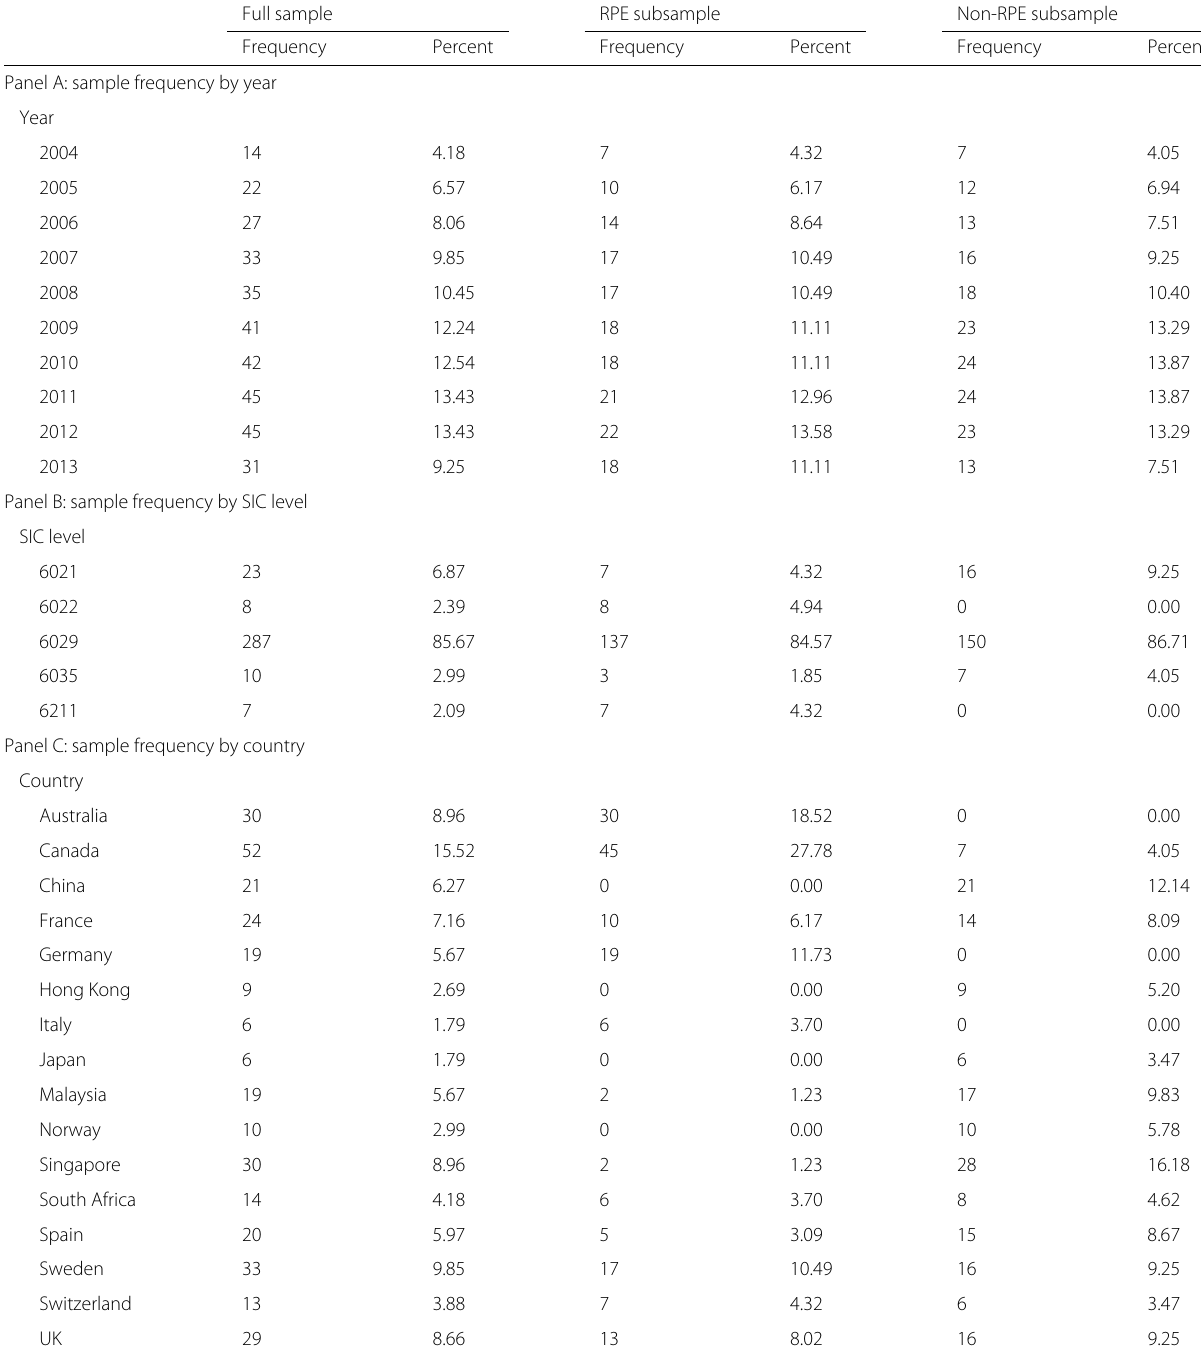
Table 1 Sample frequency by year, SIC level, and country Full sample RPE subsample Non-RPE subsample Frequency Percent Frequency Percent Frequency